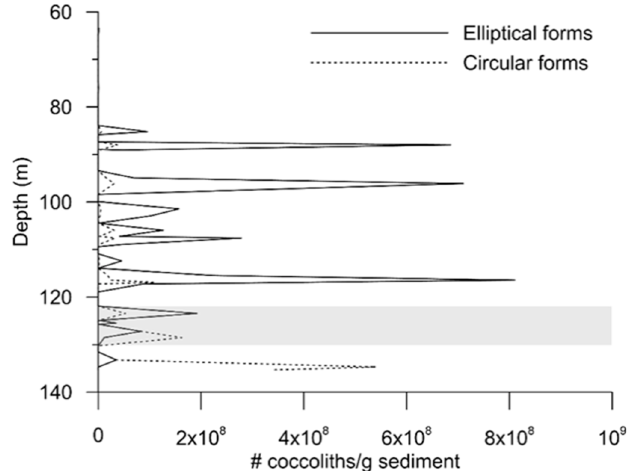
Figure 13. Absolute abundance of the calcareous nannofossil Pseudoemiliania lacunosa from 0 to 135 mbsf. Broken line shows abundance of circular variants. Solid line shows abundance of elliptical morphotypes. The gray highlighted area estimates the transition of circular-dominated to elliptical-dominated Pseudoemiliania in the core.